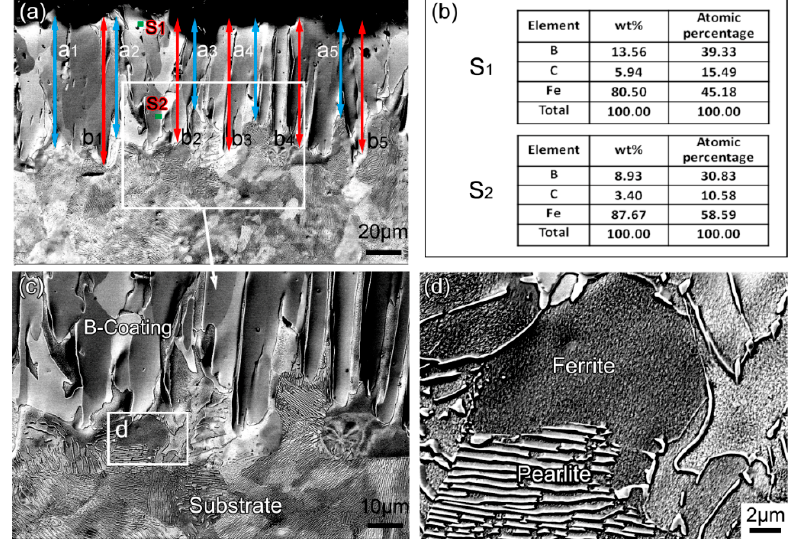
Figure 3. Sectional microstructure of the preboronizing (PB) sample: ( a ) backscattering electron imaging (BSEI) image of the coating; ( b ) energy dispersive spectroscopy (EDS) patterns of two selected points (S 1 and S 2 ) in ( a ); ( c , d ) high-magnification BSEI images corresponding to the white boxes.